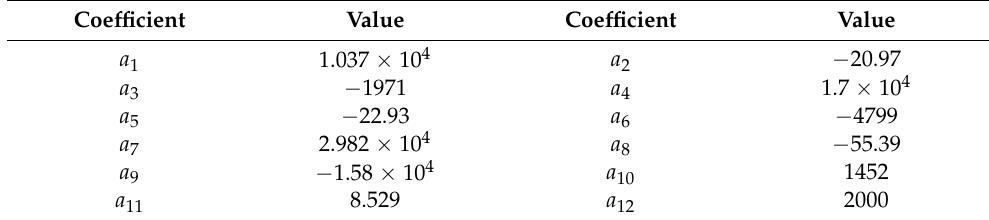
Table 6. Coefficients’ values of C 2 - SOC - T fitting